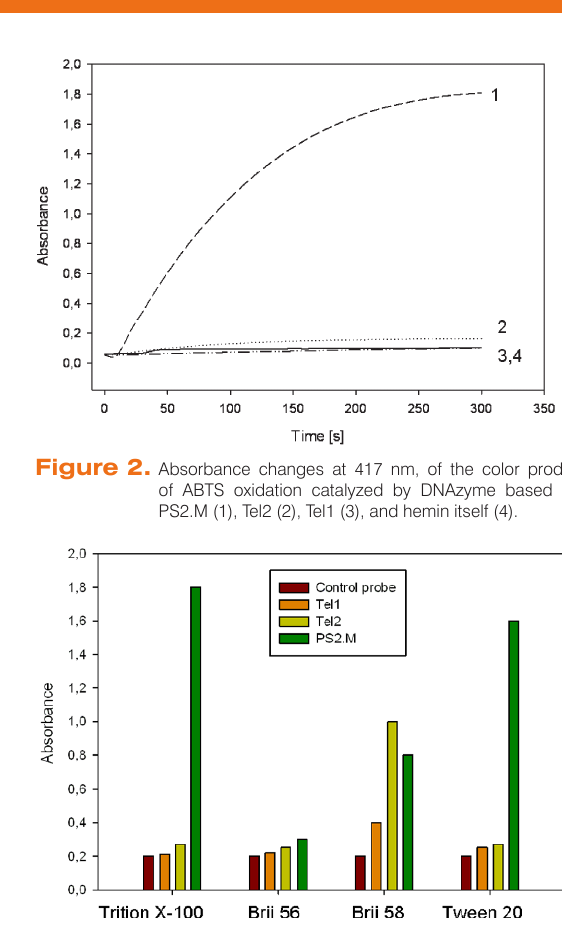
Figure 3. Comparison of absorbances at 417 nm obtained for indicator ABTS reaction catalyzed by DNAzymes in the presence of different